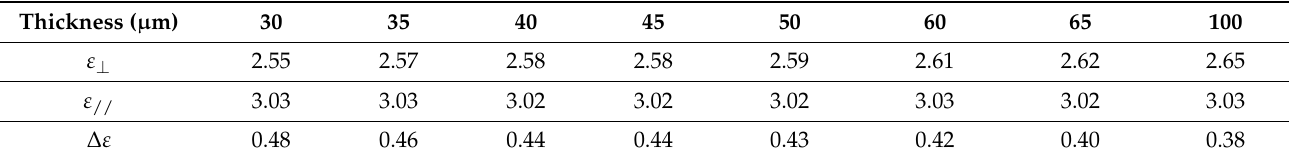
Figure 4. Permittivity as a function of the LC layer thickness for the LC S200 in the fully biased and unbiased states. Table 2. Dielectric properties of the S200 LC with different thicknesses.